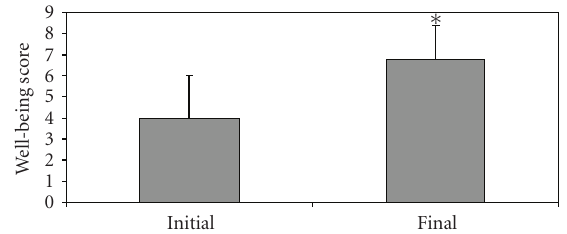
Figure 2: Well-being scores of women experiencing HB/RF and NVP at initial call and at follow-up after the use of acid-reducing pharmacotherapy; Final (marked “ ∗ ”): P < . 0001, compared to control.